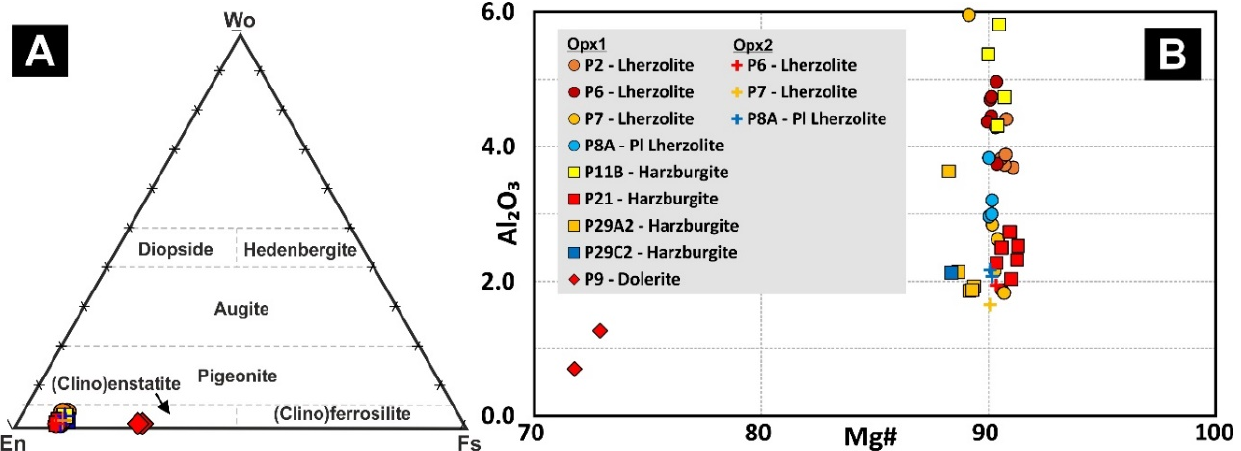
Figure 21. Orthopyroxene chemistry. ( A ) Opx Classification from [55]. ( B ) Relationship between Al 2 O 3 and Mg# = [Mg/(Mg + Fe 2+ ) × 100] atomic ratio in Opx. Al 2 O 3 and Mg# = [Mg/(Mg + Fe 2+ ) × 100] atomic ratio in